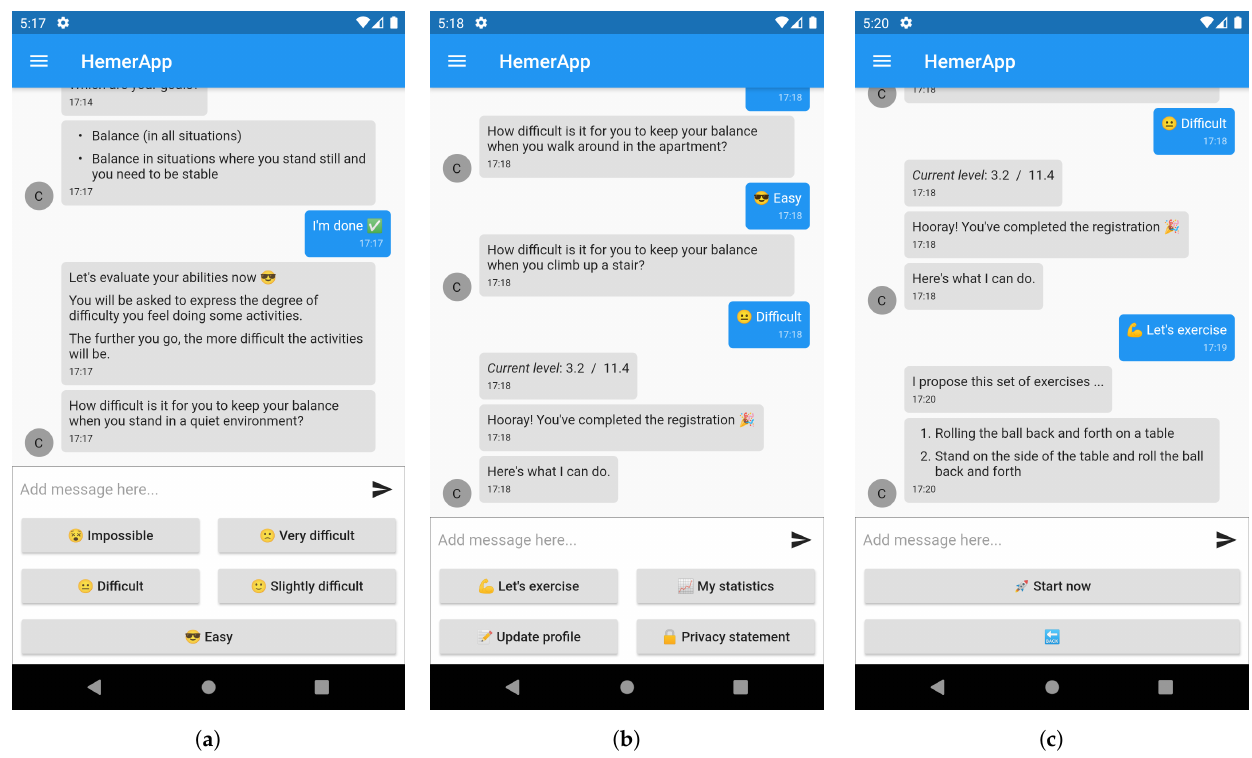
Figure 10. Self-assessment and tailored exercise request in HemerApp. ( a ) Self-assessment of physio-motor conditions. ( b ) Main menu after profile setting and self-assessment. ( c ) Request for exercises tailored to the user